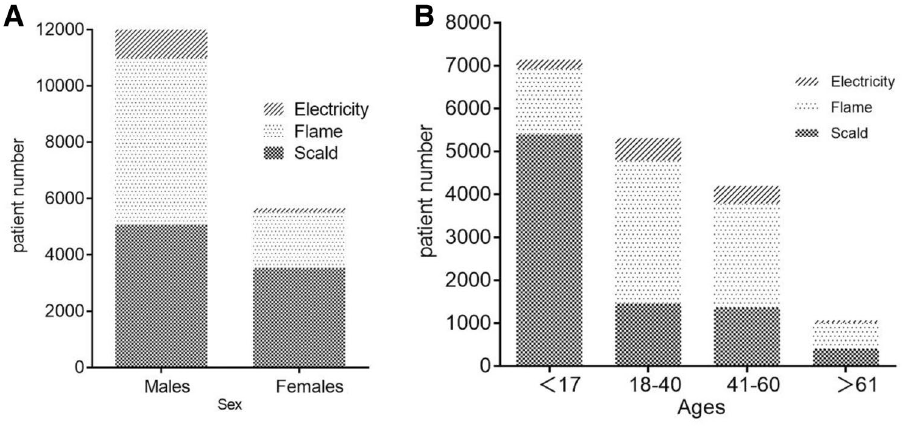
Figure 3. Etiology analysis. ( A ) Distribution of etiology by ages. ( B ) Distribution of etiology by